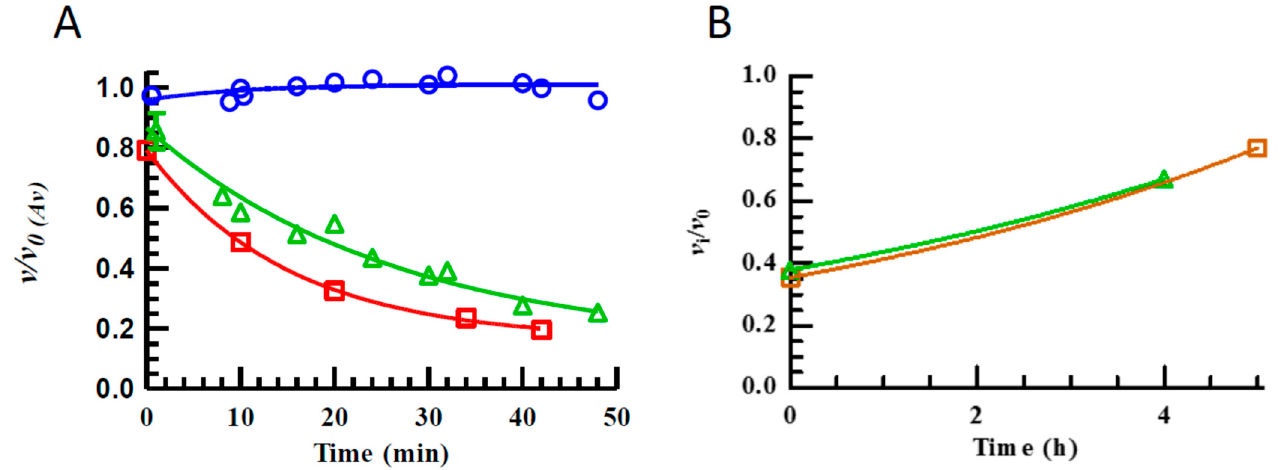
Figure 1. Time-dependent reversible inhibition of MMP-14 with TPA. ( A ): MMP-14 (45 ( ∆ ) and 5.6 ( □ ) nM) was pre-incubated at 37 °C with 10 and 11.1 μ M TPA, respectively, while controls were without TPA ( ○ ). Aliquots were withdrawn and the enzymatic activity determined. Initial rate velocities ( v ) at the different time points were divided by the average of the control velocities ( v 0(Av) ). The results for the high concentration of MMP-14 in the pre-incubation assay are from two independent experiments. ( B ): Two independent experiments ( Δ and □ ) of micro-dialysis (4 °C) of MMP-14 (45 nM) pre-incubated at 37 °C. Aliquots were withdrawn after various time points and the initial rate velocities determined. The velocity ratio v i / v 0 was determined for each time point where v i is the initial rate of the MMP-14/TPA sample and v 0 of the MMP-14 control at the same dialysis time